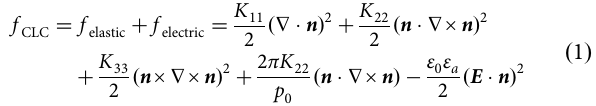
BCs (Supplementary Fig. 3) by varying the elastic anisotropy associated with bend and twist deformation ( ) and the e normalized electric fi eld strength E